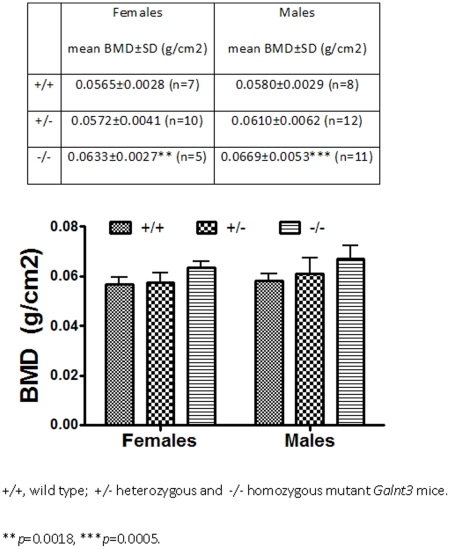
Areal BMD derived from DEXA analysis of 15- to 16-week-old
GALNT3 mutant and wild-type mice.P-values refer to Student t-test for two-way ANOVA across the three
genotypes.